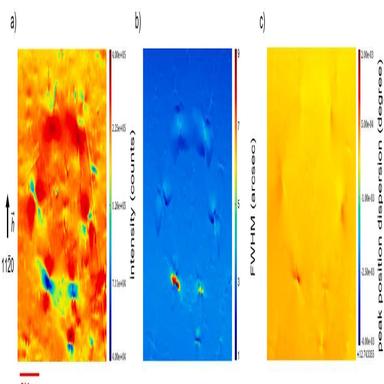
RCI maps of a GaN substrate (1120reflection, 30 keV) showing a hexagonal arrangement of dislocation bunches we call "honeycomb", (a) integrated intensity map b) FWHM map and c) peak position map).